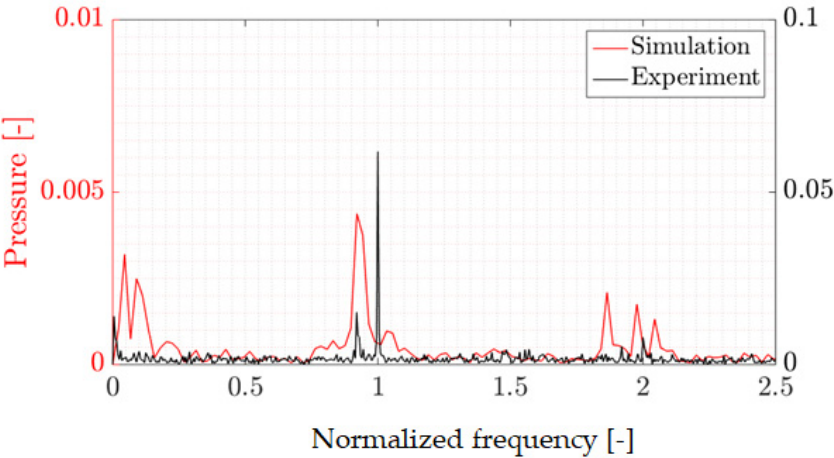
Figure 12. Amplitude spectrum of the pressure at P-PS-2 (pressure side, center area of the runner blade). Two vertical axes are used; numerical results—red, experimental results—black.